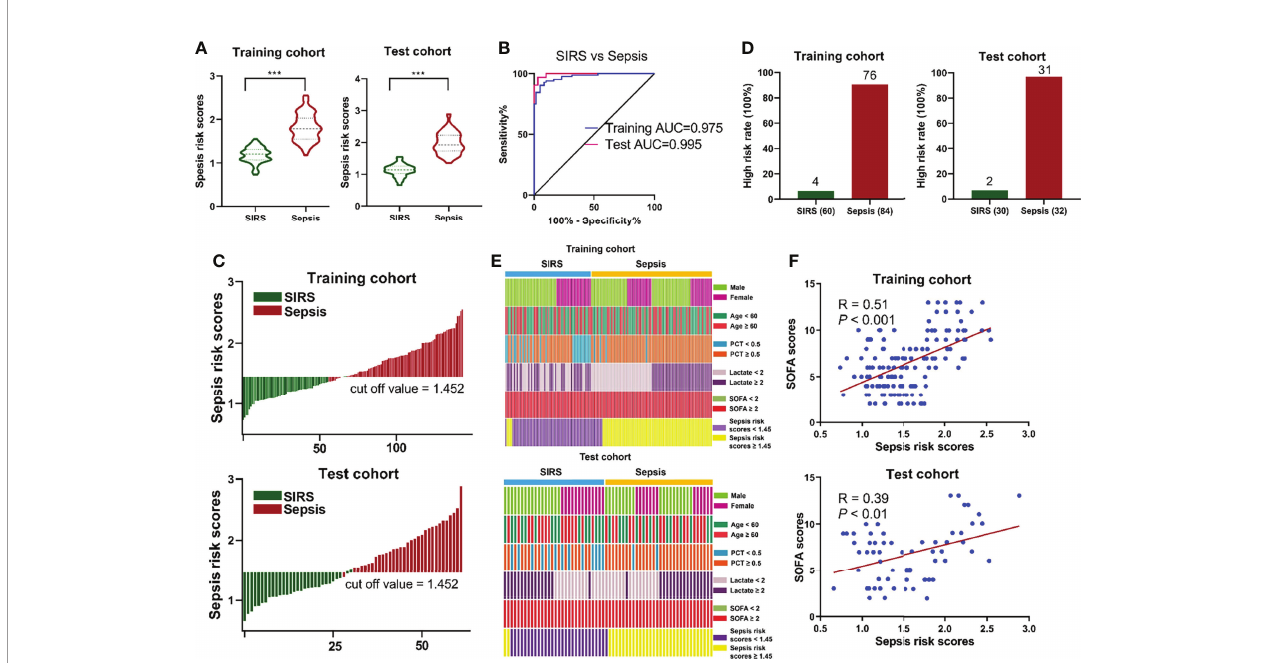
FIGURE 4 | (A) Respective values of sepsis risk scores between the sepsis and SIRS groups. The sepsis risk scores were constructed as follows: Ln (sepsis risk scores) = 0.2755 × Ln (5-Oxoproline) + 0.2125× Ln (L-Kynurenine) + 0.1286 × Ln (Leukotriene D4) - 2.2061. (B) ROC analysis of sepsis risk scores in predicting sepsis. (C) An optimal threshold point value was de fi ned as 1.452, and all participants were divided into low-risk (<cutoff) and high-risk (>cutoff) score groups. (D) Analysis of high risk rate between the sepsis and SIRS groups. (E) Correlation of sepsis incidence and demographic and clinical characteristics, including age, sex, lactate and SOFA scores, and sepsis risk scores. (F) Correlation analysis between sepsis risk scores and SOFA scores. (***, p <